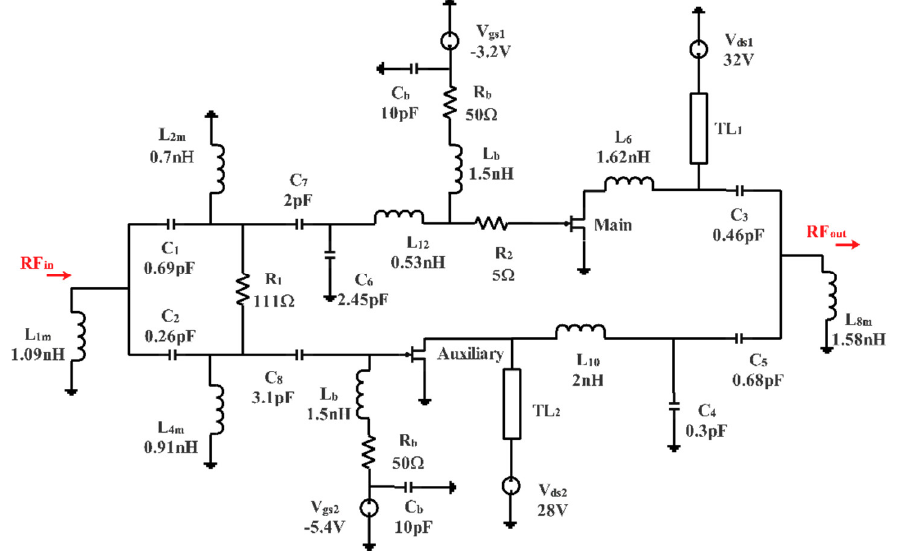
Figure 10. The schematic of the proposed DPA.